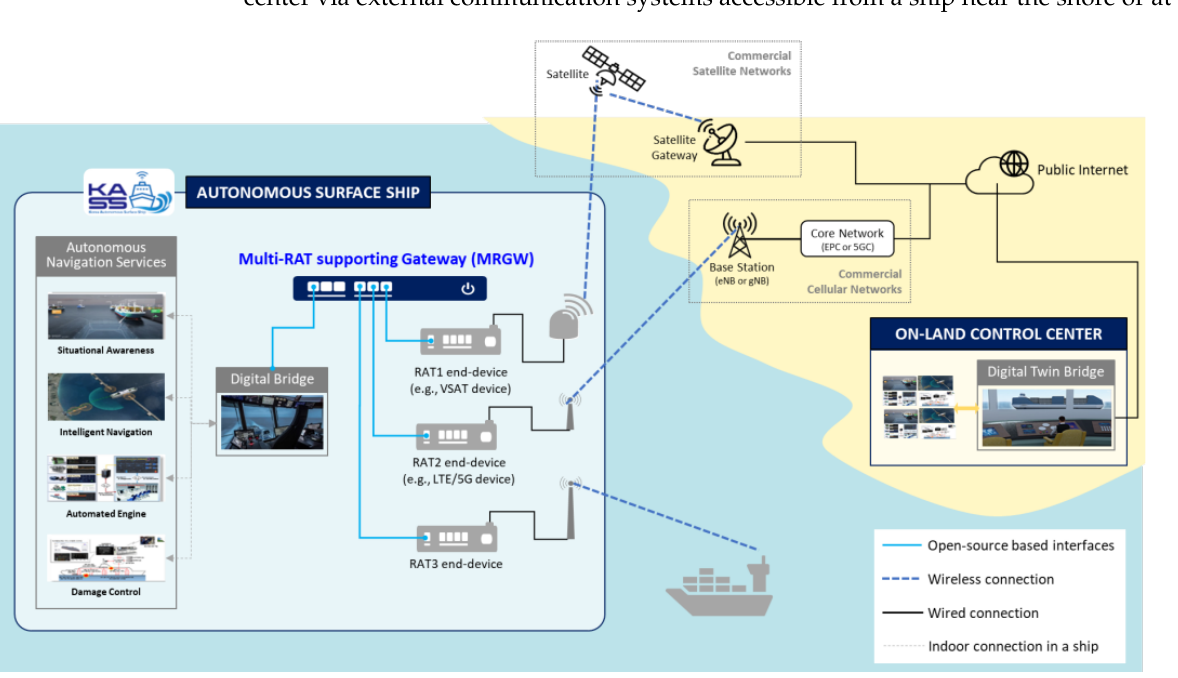
Figure 1. System Model.